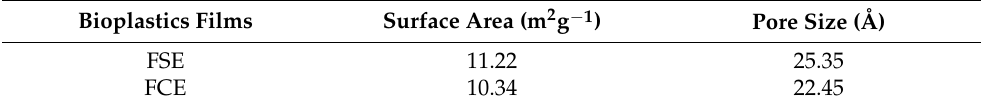
Table 7. Barret, Joyner, and Halenda (BJH) characterization of bioplastic films with and without the extract (FSE and FCE,